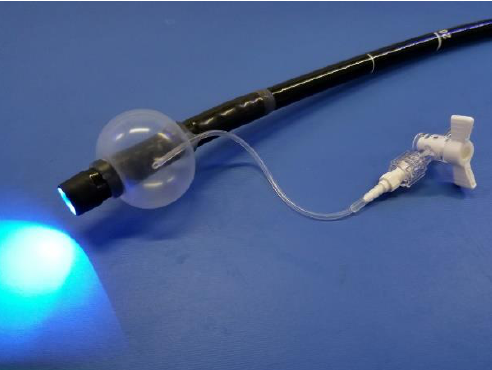
Figure 1. Flexible magnifying endoscopy with narrow band imaging (ME-NBI) with a soft black hood and an occlusion balloon.